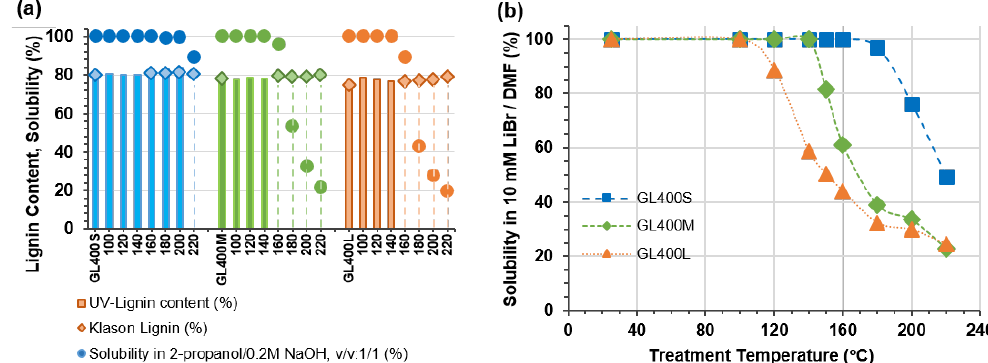
Figure 1. Lignin content (UV and Klason) of GL400S, GL400M, and GL400L after heat treatment at temperatures of 100 to 220 °C for 1 h and their solubility in the 2-propanol:0.2M NaOH ( v / v :1/1) solvent used for UV lignin analysis ( a ) and in the 10 mM LiBr/DMF solvent used for SEC analysis ( b ).